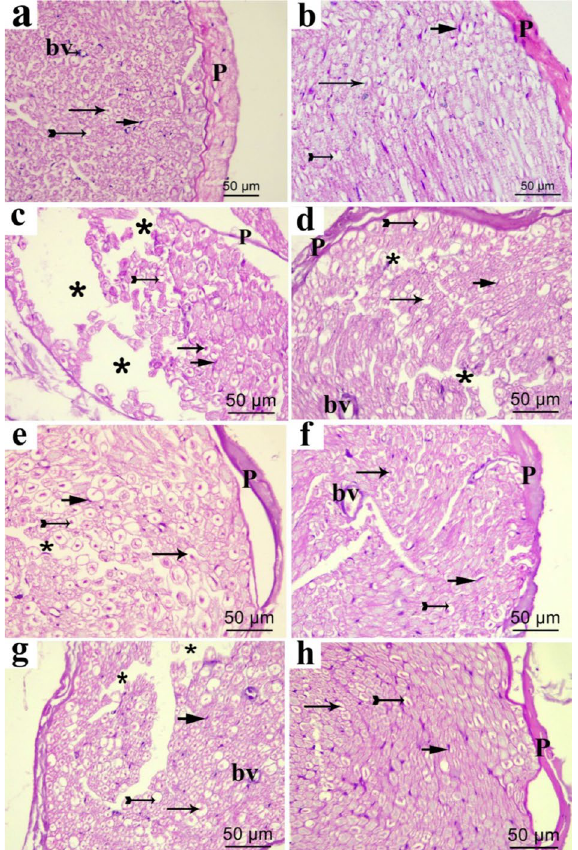
Figure 6. Representative photomicrographs of transverse sections of sciatic nerve in different experimental groups, ( a ) control group; ( b ) sham group; ( c ) CCI group; ( d ) pregabalin group; ( e ) TF (p.o., 200 mg/kg); ( f ) TF (p.o., 400 mg/kg). ( g ) TA (p.o., 200 mg/kg); ( h ) TA (p.o., 400 mg/kg). Arrow, bifid arrow, short arrow and astriex illustrate axoplasm, area of dissolved myelin, Schwann cells nuclei and wide separation between the nerve fibers, respectively. (P) perineurium; (bv) blood vessel. Scale bar, 50 μm ×